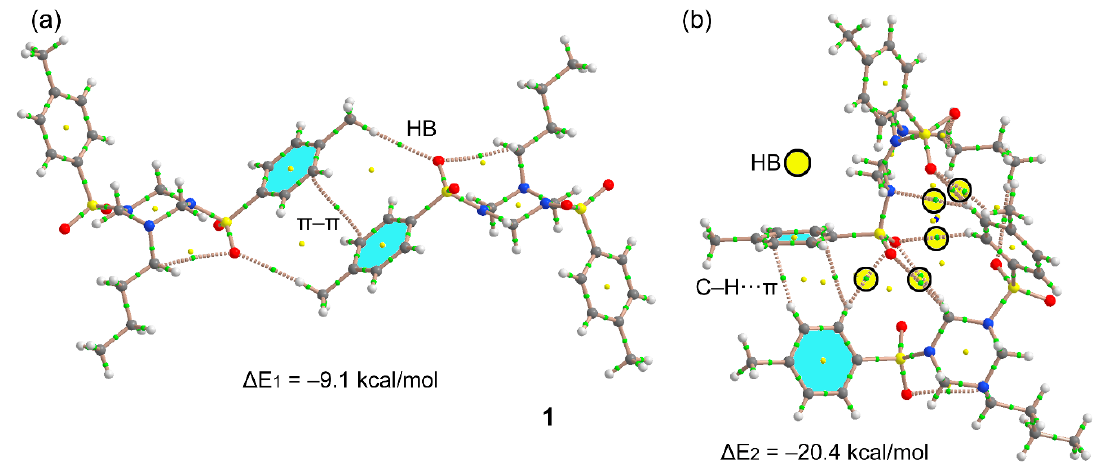
Figure 9. ( a , b ) Distribution of bond, ring and cage critical points (green, yellow and blue spheres, respectively) and bond paths in two dimers of complex 1 . The C–H···O bonds are highlighted in ( b ).